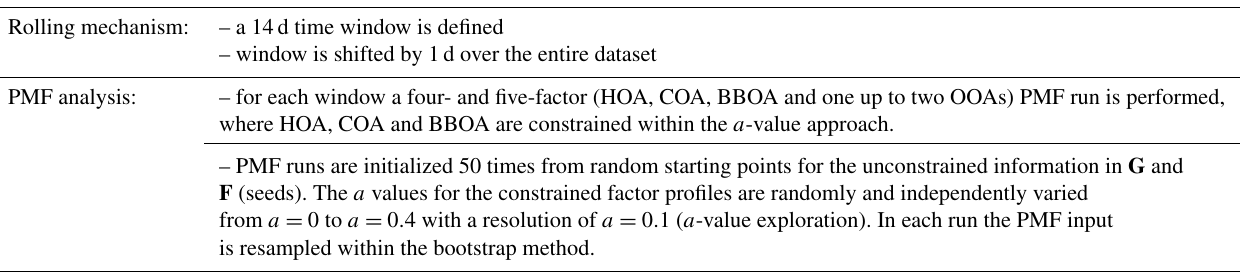
Figure 1. The mathematical metric Q/Q exp (left axis, red points) and the percent of non-modeled time points (non-modeled) (right axis, blue points) over the entire dataset are reported as a function of window size ( s win ), maximum a value ( a max ), and number of PMF repeats per window ( x PMF ). In each plot, two of these three parameters are fixed at their optimum values and the third is varied: (a) s win , (b) a max , and (c) x PMF . Optimum values are s win = 14d, a max = 0 . 4, and x PMF = 50. For all runs, criteria are defined as described in Sect. 2.3.3. Table 1. Overview of the rolling mechanism and the repeats of the PMF